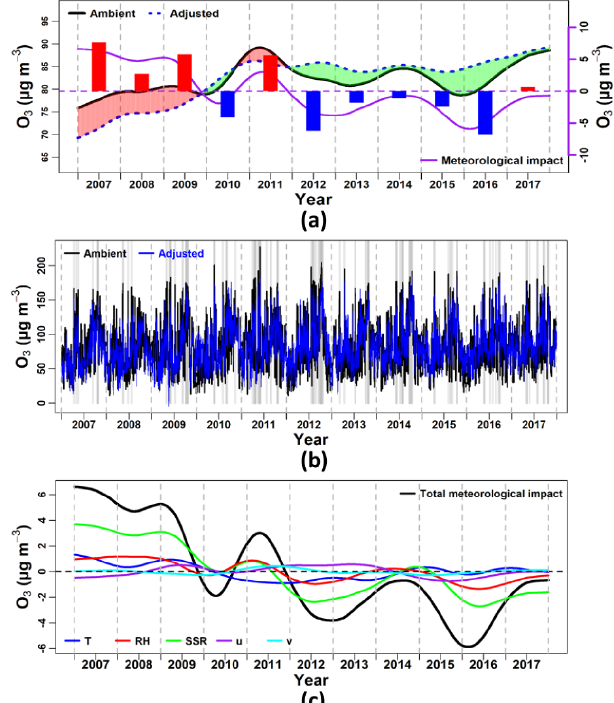
Figure 3. (a) Long-term trends of ambient ozone (left y axis), me- teorologically adjusted ozone (left y axis), and the meteorological impact (right y axis) in the Pearl River Delta during the 2007–2017 period. Periods with positive and negative meteorological impacts are shaded using red and green, respectively. Red and blue bars rep- resent respective ozone increases and reductions attributed to mete- orology in each year. (b) The ozone concentration time series be- fore (black) and after (blue) meteorological adjustment. Gray ar- eas represent periods with ozone concentrations over 160µgm − 3